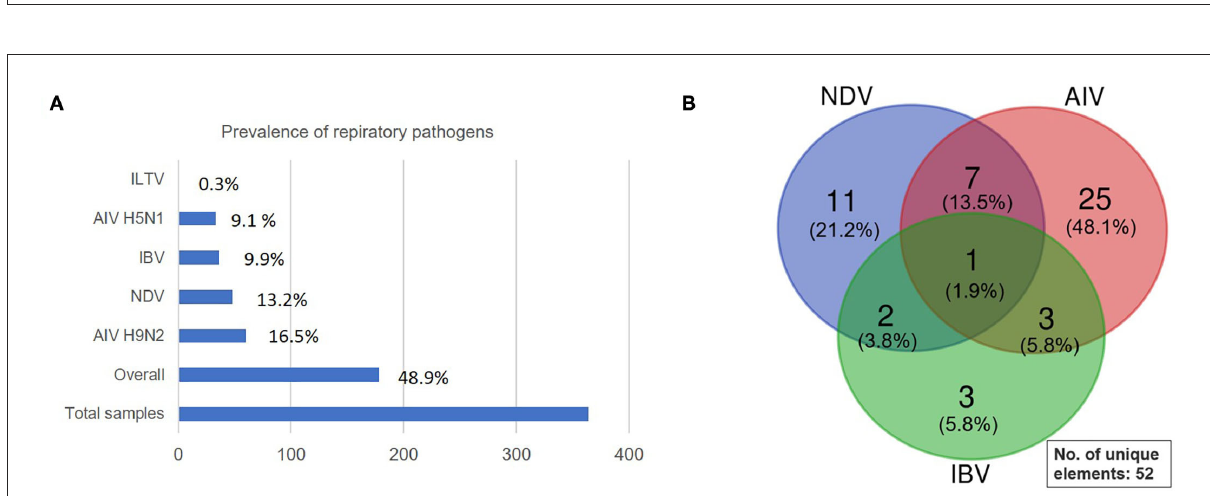
FIGURE4 Overall prevalence of respiratory pathogens. (A) A clustered bar showing the overall prevalence of respiratory pathogens identified in the current study. (B) Venn diagram showing the presence of co-infections of 2–3 different respiratory viruses detected by multitarget simultaneous RT-qPCR